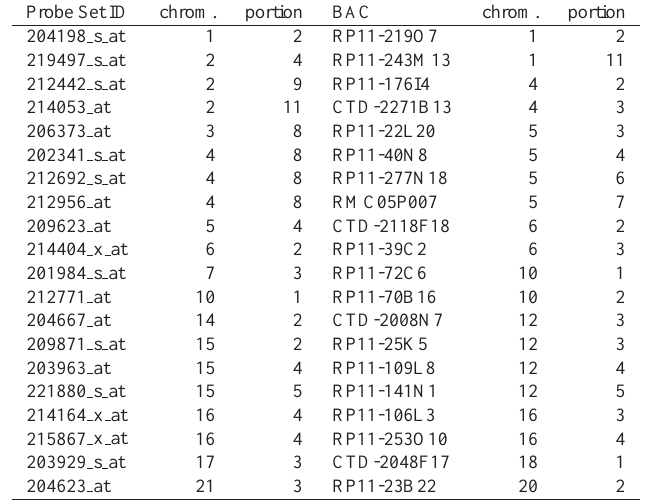
Table 5: Chromosome portions of the top-20 affy probesets and top-20